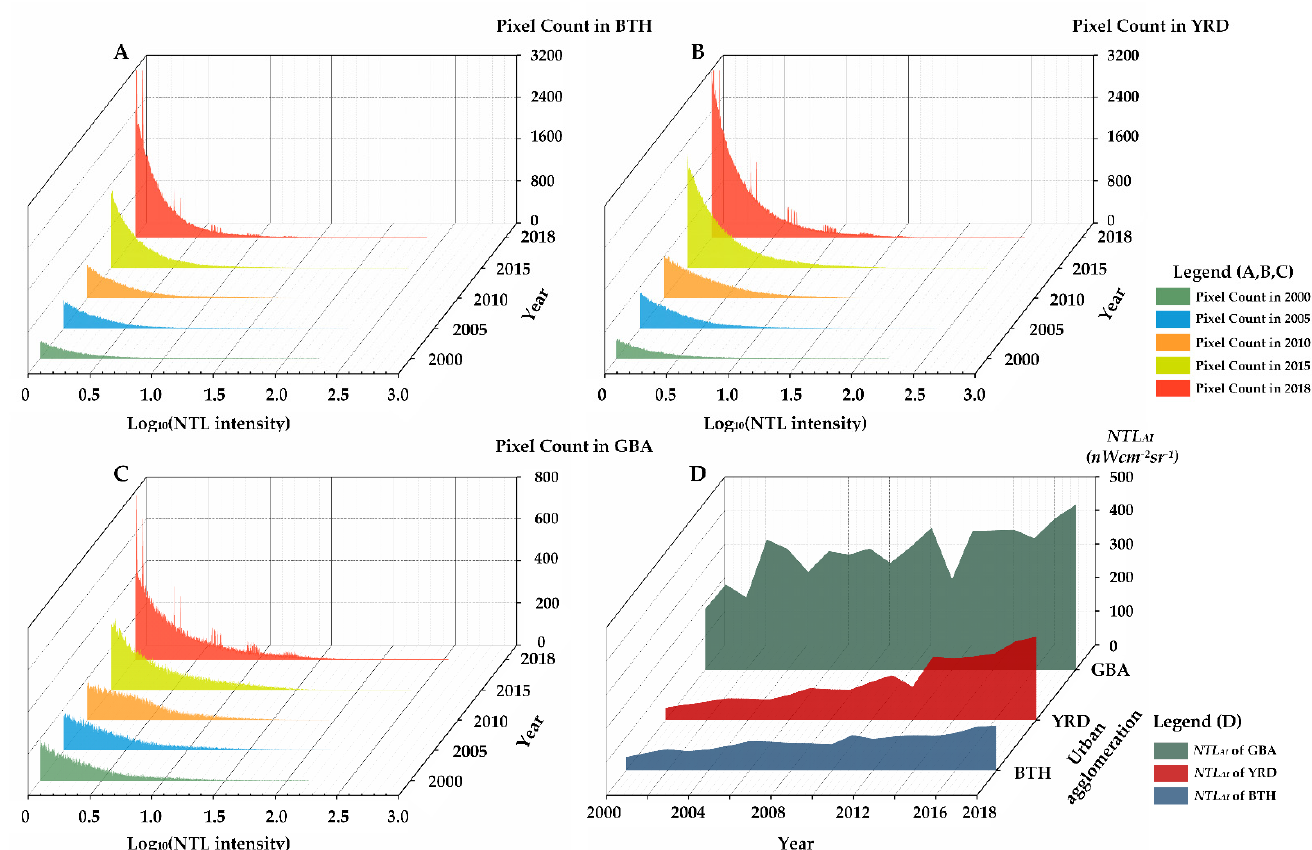
Figure 3. Temporal variations in the log-transformed NTL intensities and corresponding lit pixel counts in the three urban agglomerations ( A : BTH, B : YRD, C : GBA) from 2000 to 2018. Panel ( D ) indicates the change in NTL AI in the three urban agglomerations from 2000 to 2018.